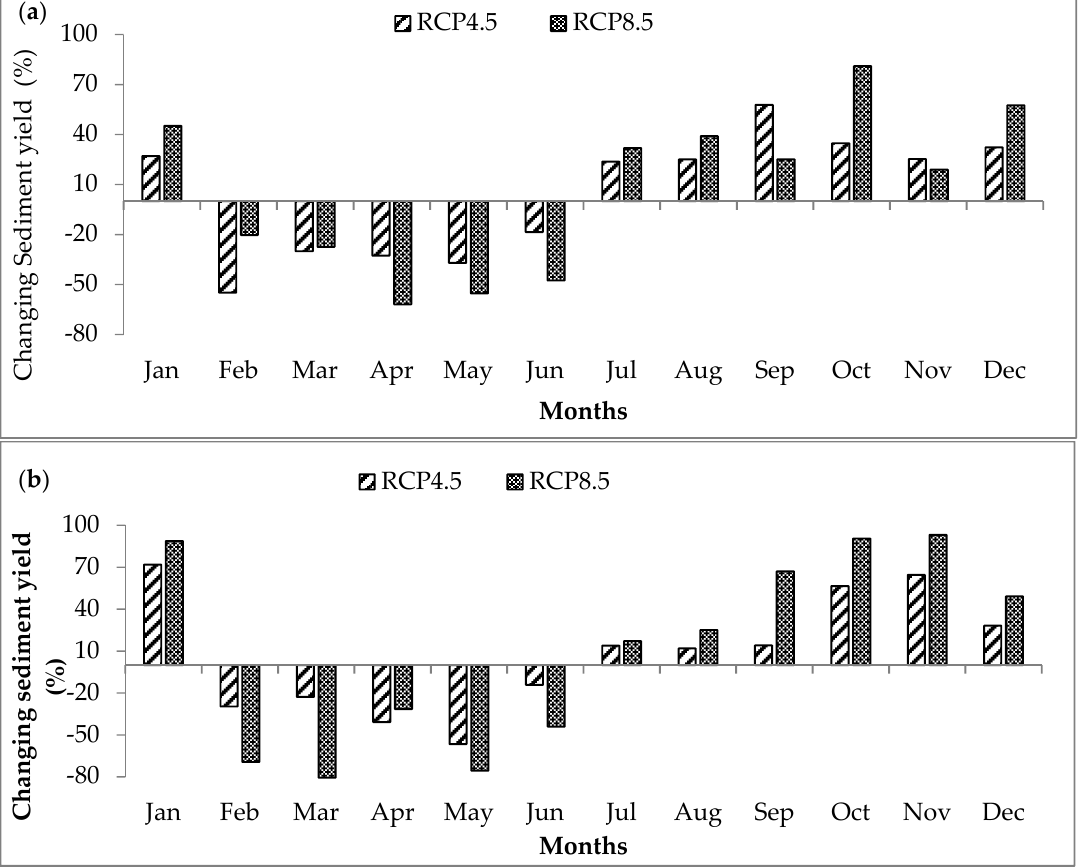
Figure 12. Projected change of mean monthly sediment yield ( a ) in the 2030s ( b ) in the 2060s from the baseline period in the Logiya watershed.